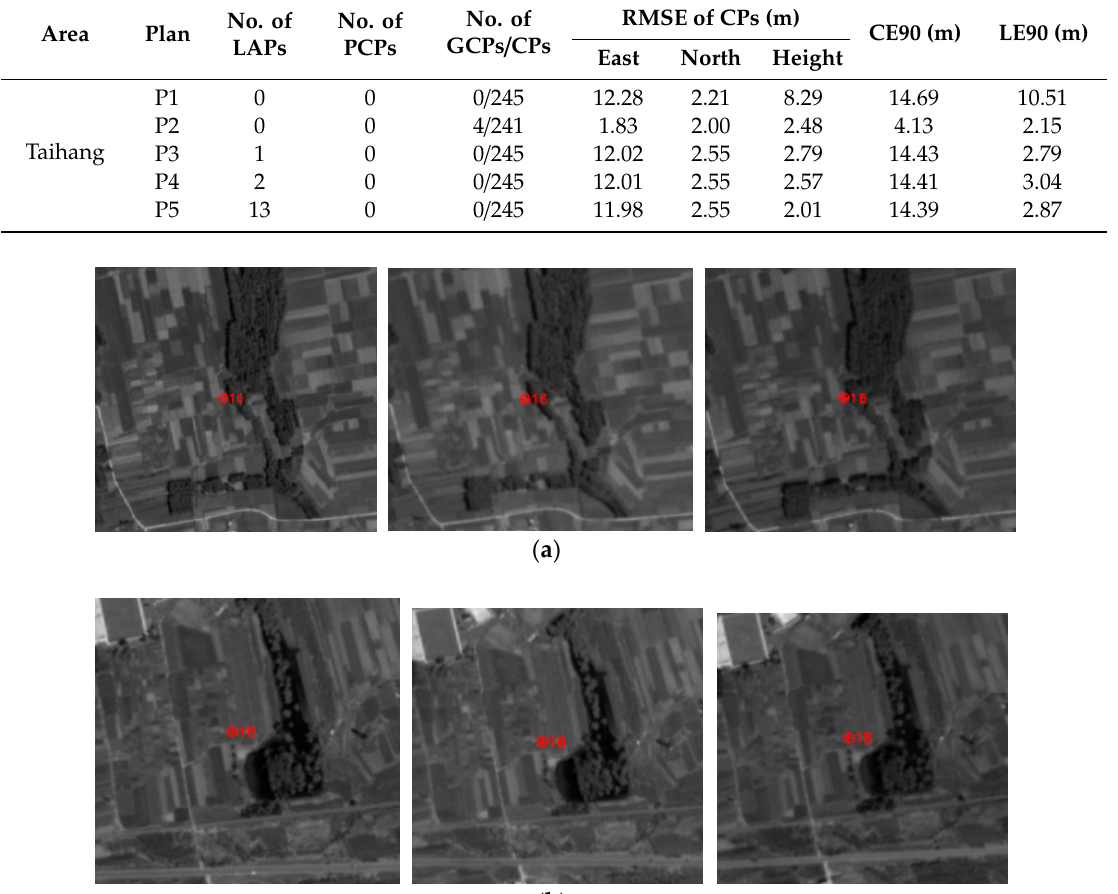
Table 6. Accuracy statistics for the proposed combined adjustment under different adjustment schemes in the Taihang area.